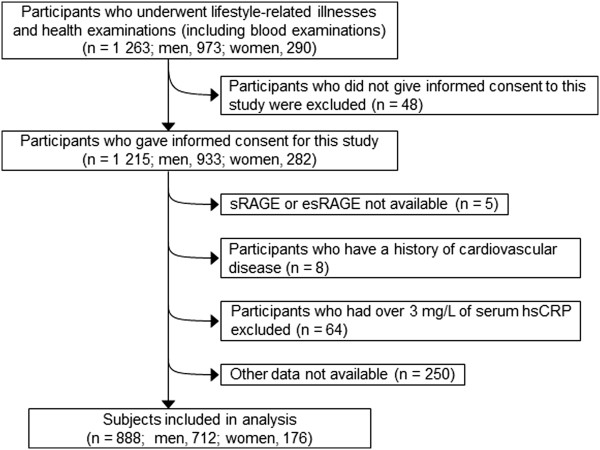
Flow chart of the sample selection process. sRAGE, soluble receptor for advanced glycation end products. esRAGE, endogenous secretory RAGE. hsCRP, high sensitivity C-reactive protein.